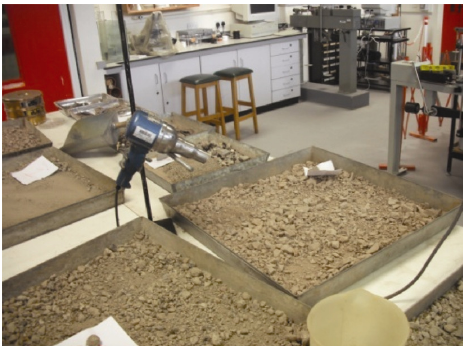
Fig. 3. Drying with warm air dryer